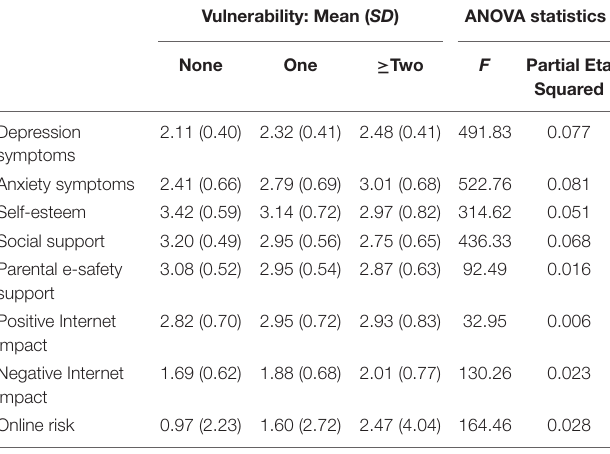
TABLE 2 | One way analysis of variance and descriptive statistics illustrating group-based